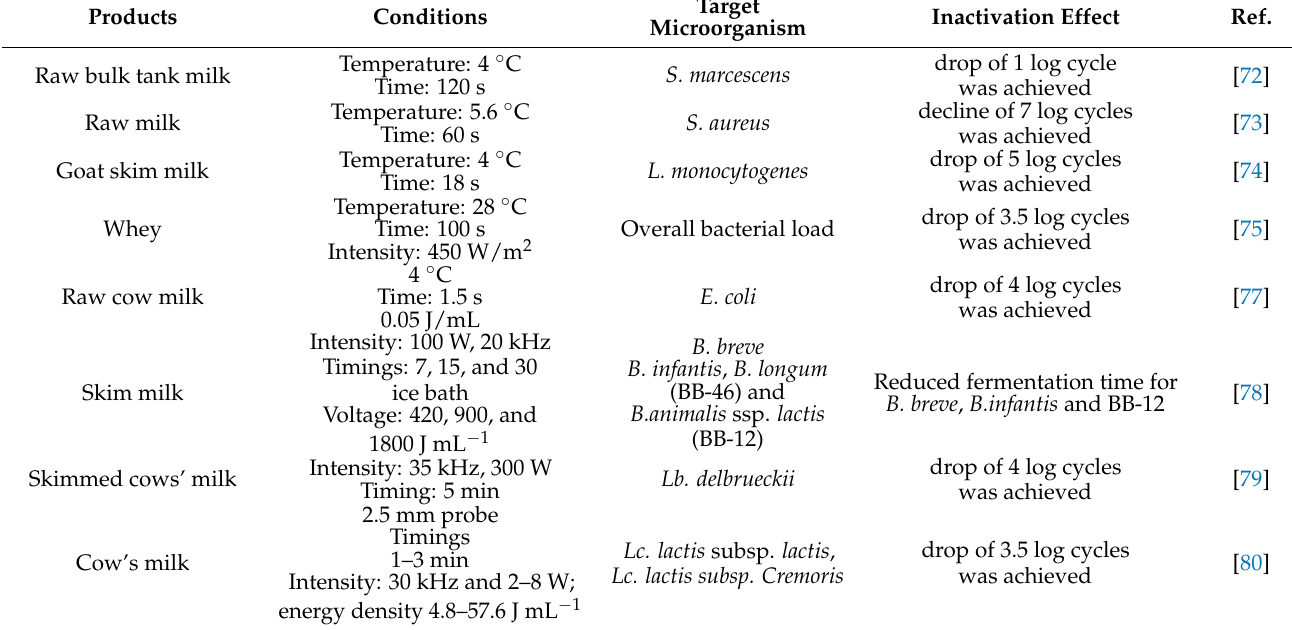
Table 4. Inactivation of microorganisms by ultraviolet (UV) treatment in milk and milk products.